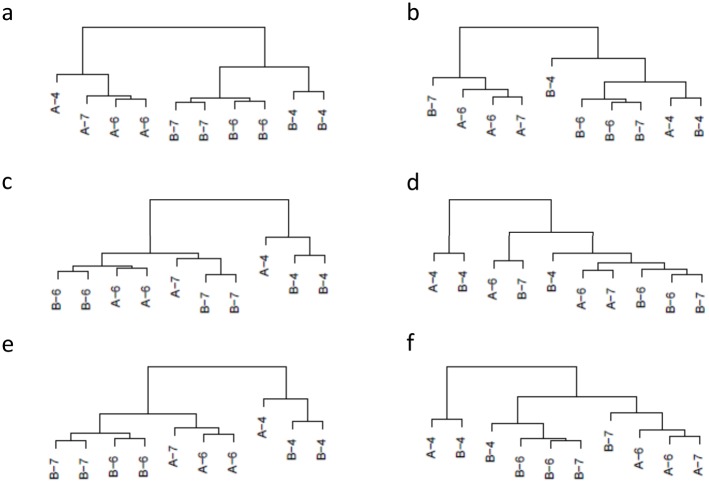
Typical dendrograms obtained for plasmode datasets from Bottomly experimental data with two dissimilarity measures under three scenarios.Dendrograms obtained using complete linkage hierarchical clustering based on Poisson dissimilarity (poi) are presented in the left column (a, c and e), and dendrograms based on Euclidean distance calculated from raw normalized data (rnr) are presented in right column (b, d, f). The rows correspond to three scenarios with different percentage of differentially expressed (DE) transcripts: 1) DE[100%] (a and b), 2) DE[10%]+nonDE[90%] (c and d), and 3) DE[20%]+nonDE[80%] (e and f). Sample labels correspond to main treatment (A or B) and flowcell number (4, 6 or 7). Dendrograms based on poi separates samples according to the expected sources of variation; in (a), only DE transcripts, samples are arranged in two separate groups following treatment labels; in (c), with a predominant number of non DE transcripts, the structure of groups is dominated by flowcell characteristics in addition to main treatment: and in (e) an in-between scenario, the dendrogram presents an intermediate group structure. Dendrograms based on rnr do not resemble any expected configuration.